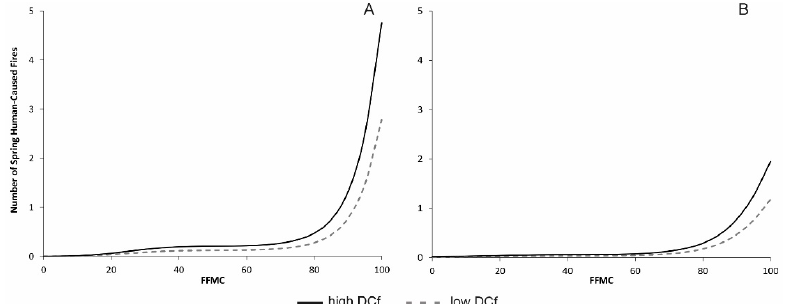
Figure 3. Examples of the resultant zero-inflated Poisson models for the daily number of human-caused spring fires and FFMC (Fine Fuel Moisture Content) under low and high DC f values for ( A ) Grande Prairie and ( B ) Kirkland Lake. Values for low and high DC f are the same as those shown in Figure 2. The authors would like to apologize for any inconvenience caused to the readers by these changes.